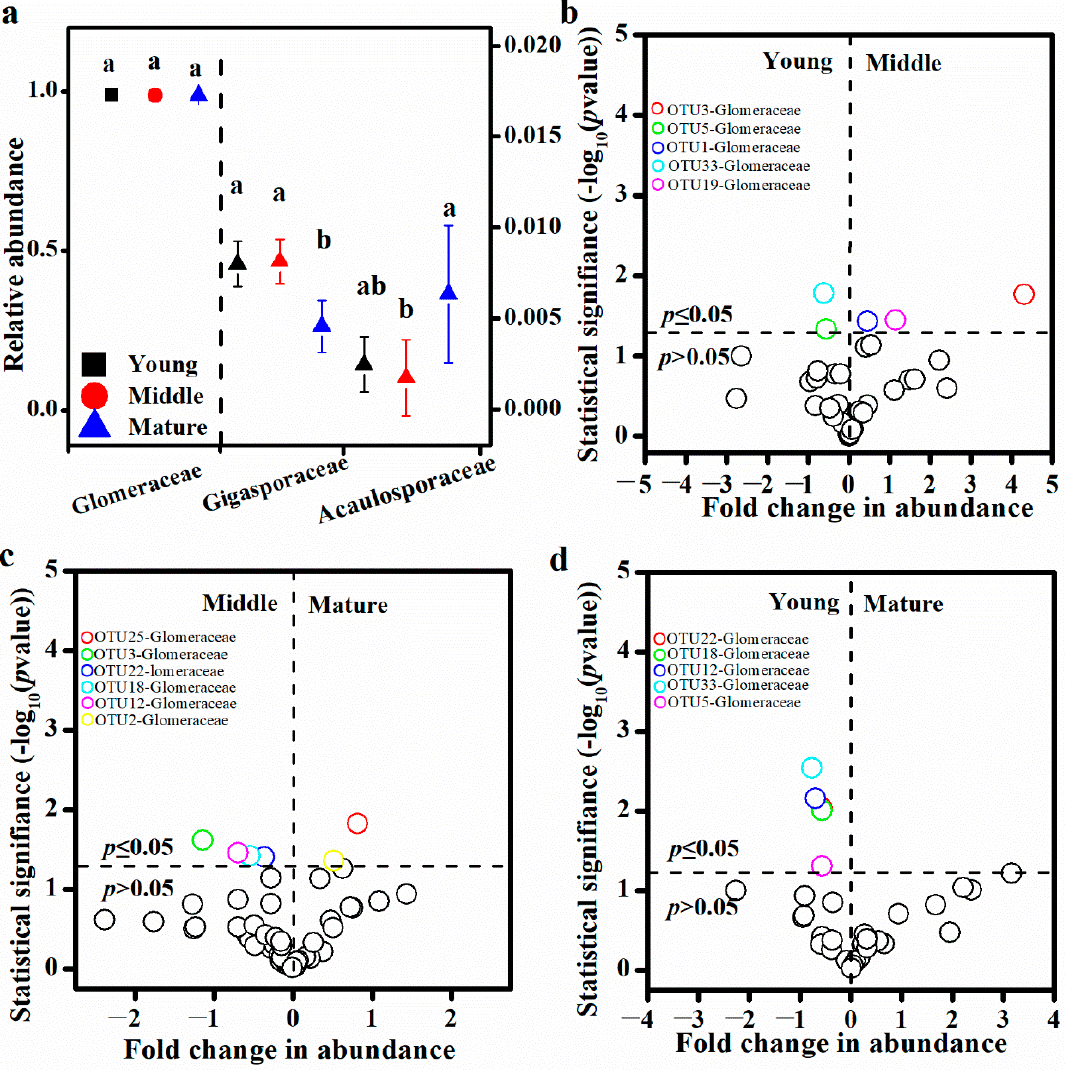
Figure 5. Relative abundance of AM fungal families under different plantations ( a ), Volcano plot of MV-GLM modelled shifts in AM fungal abundances in middle-aged plantation relative to young plantation ( b ), mature plantation relative to middle-aged plantation ( c ) and mature plantation relative to young plantation ( d ). Colored points represent OTUs abundances were significantly shifted ( p < 0.05), whereas hollow points representing OTUs abundances were not significantly altered ( p > 0.05). AM fungal OTUs in the left were more abundant in the left treatment, while OTUs in the right were more abundant in the right treatment.